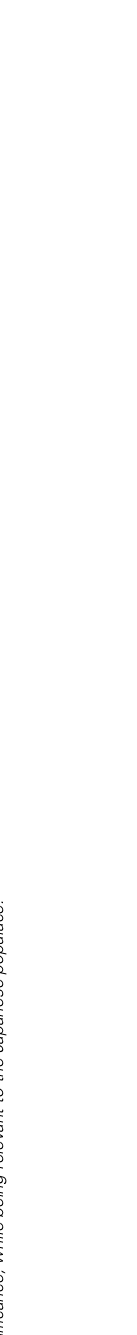
respectively. The graph plotting the average free will belief scores for subjects with particular paranormal knowledge scores